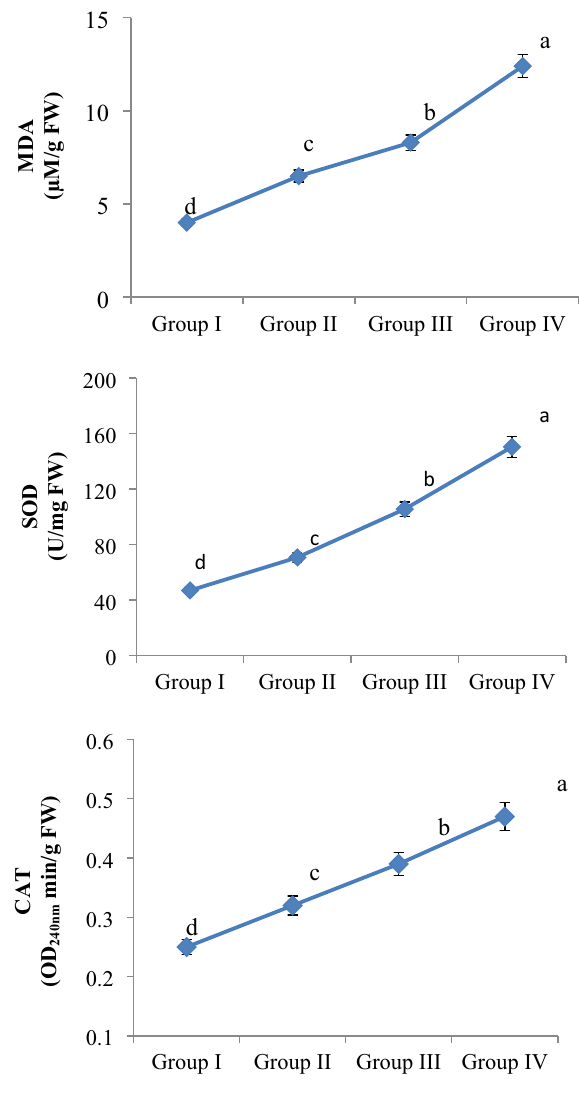
Figure 5. MnCl 2 effects on MDA level, SOD and CAT enzyme activities. Group I: Control, Group II: 250 µM MnCl 2 , Group III: 500 µM MnCl 2 , Group IV: 1000 µM MnCl 2 . Data are shown as mean ± SD (n = 10). The averages shown with different letters (a–d) are statistically significant at p <